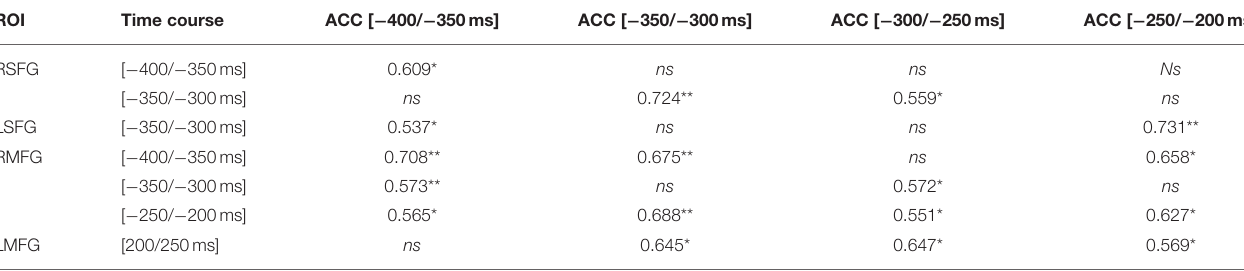
ACC, Anterior Cingulate Cortex; LMFG, Left Median Frontal Gyrus; RMFG, Left Median Frontal Gyrus; RSFG, Right Superior Frontal Gyrus; LSFG, Left superior Frontal Gyrus. * p < 0.05, ** p < 0.01, ns,